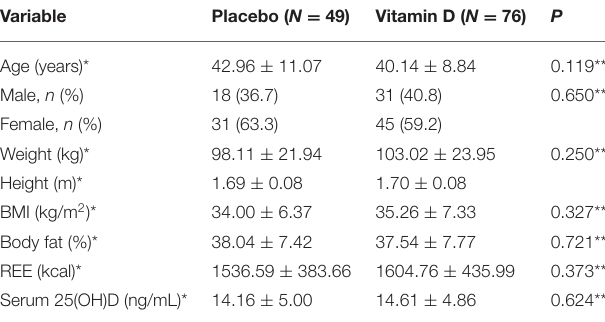
TABLE 1 | Baseline characteristics of study